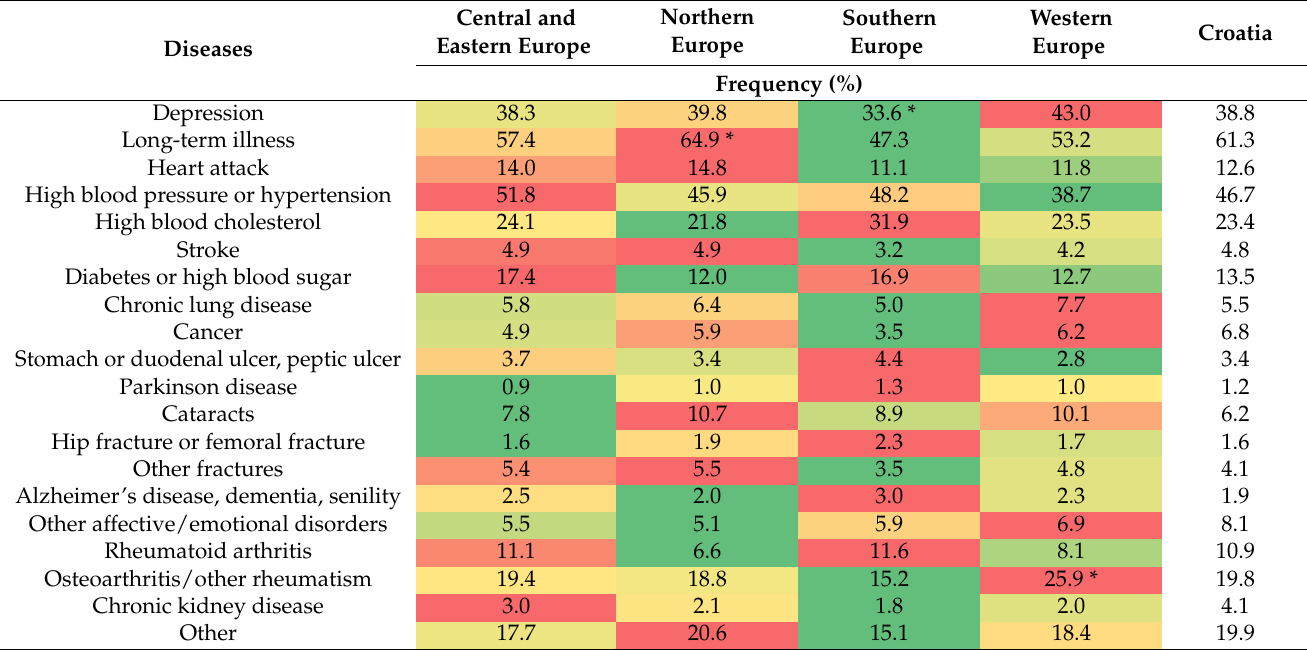
Table A5. Disease frequency (ever diagnosed/currently having) in the population group aged 50 and over, according to European